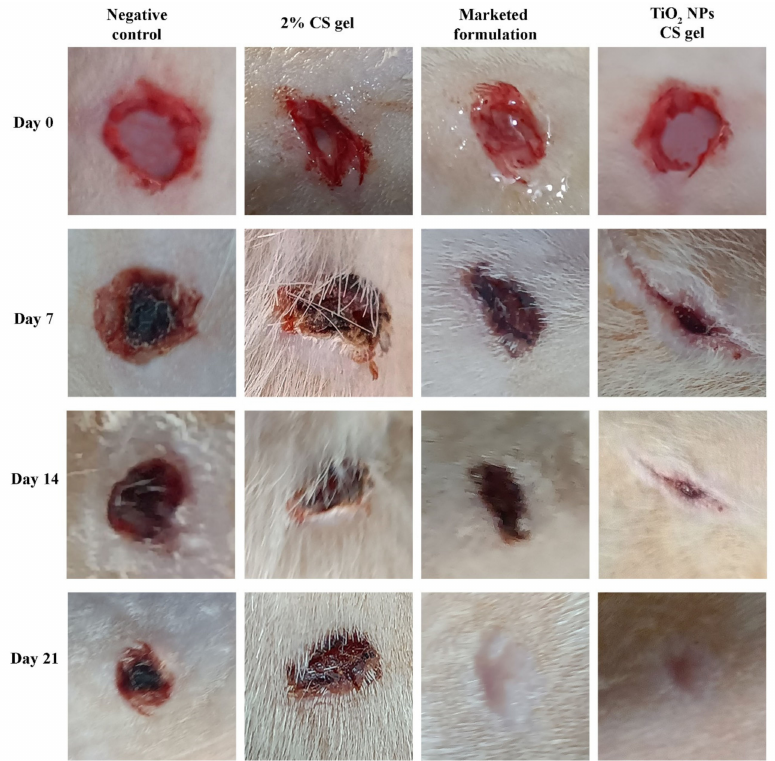
Figure 7. Wound healing efficacy of CS gel, CS gel containing TiO 2 NPs, and marketed product in diabetic wounds of Wistar